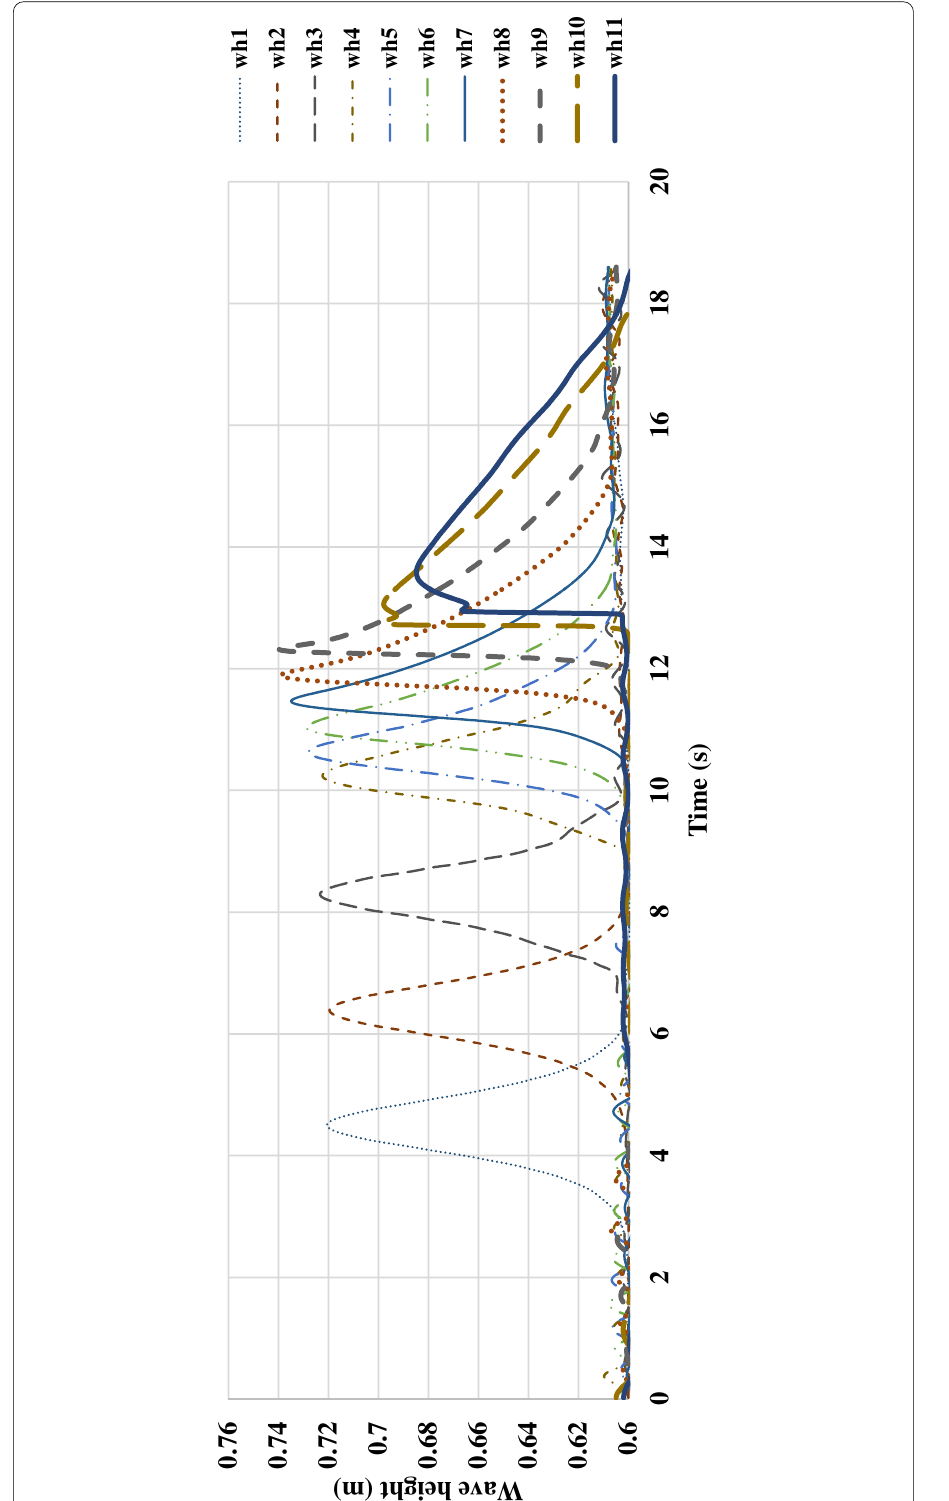
Fig. 4 Wave surface elevation time histories at the different monitoring